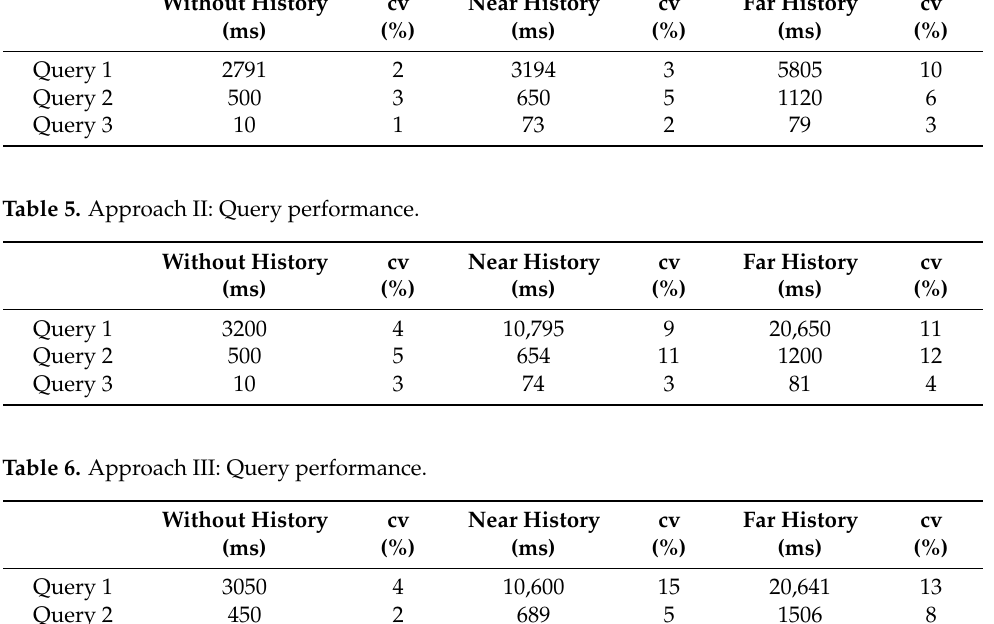
Table 4. Approach I: Query performance.